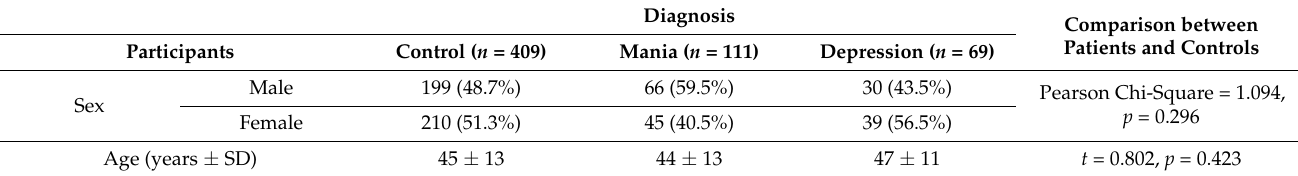
Table 1. Sex and age distribution of the participants per diagnosis.